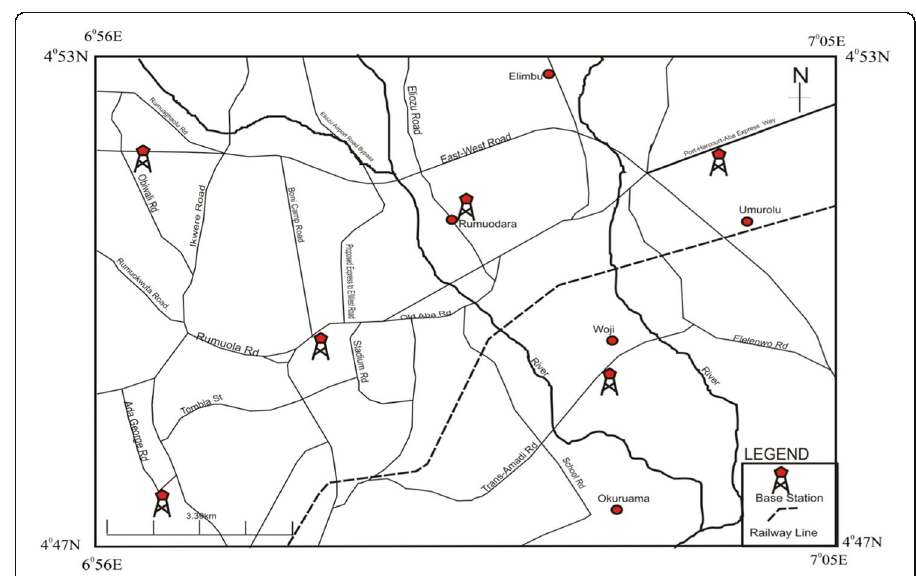
Fig. 3 A map showing eNodeBs locations in Port Harcourt City